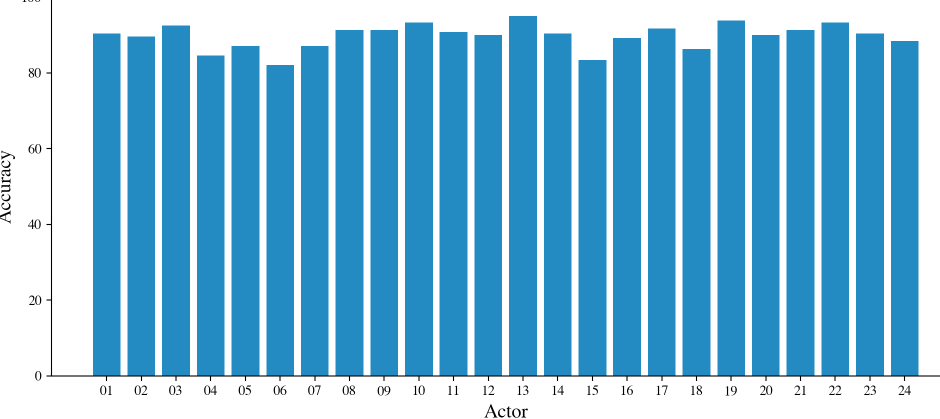
Figure 10. Speaker-independent emotion recognition. Accuracy achieved for each actor of RAVDESS dataset.